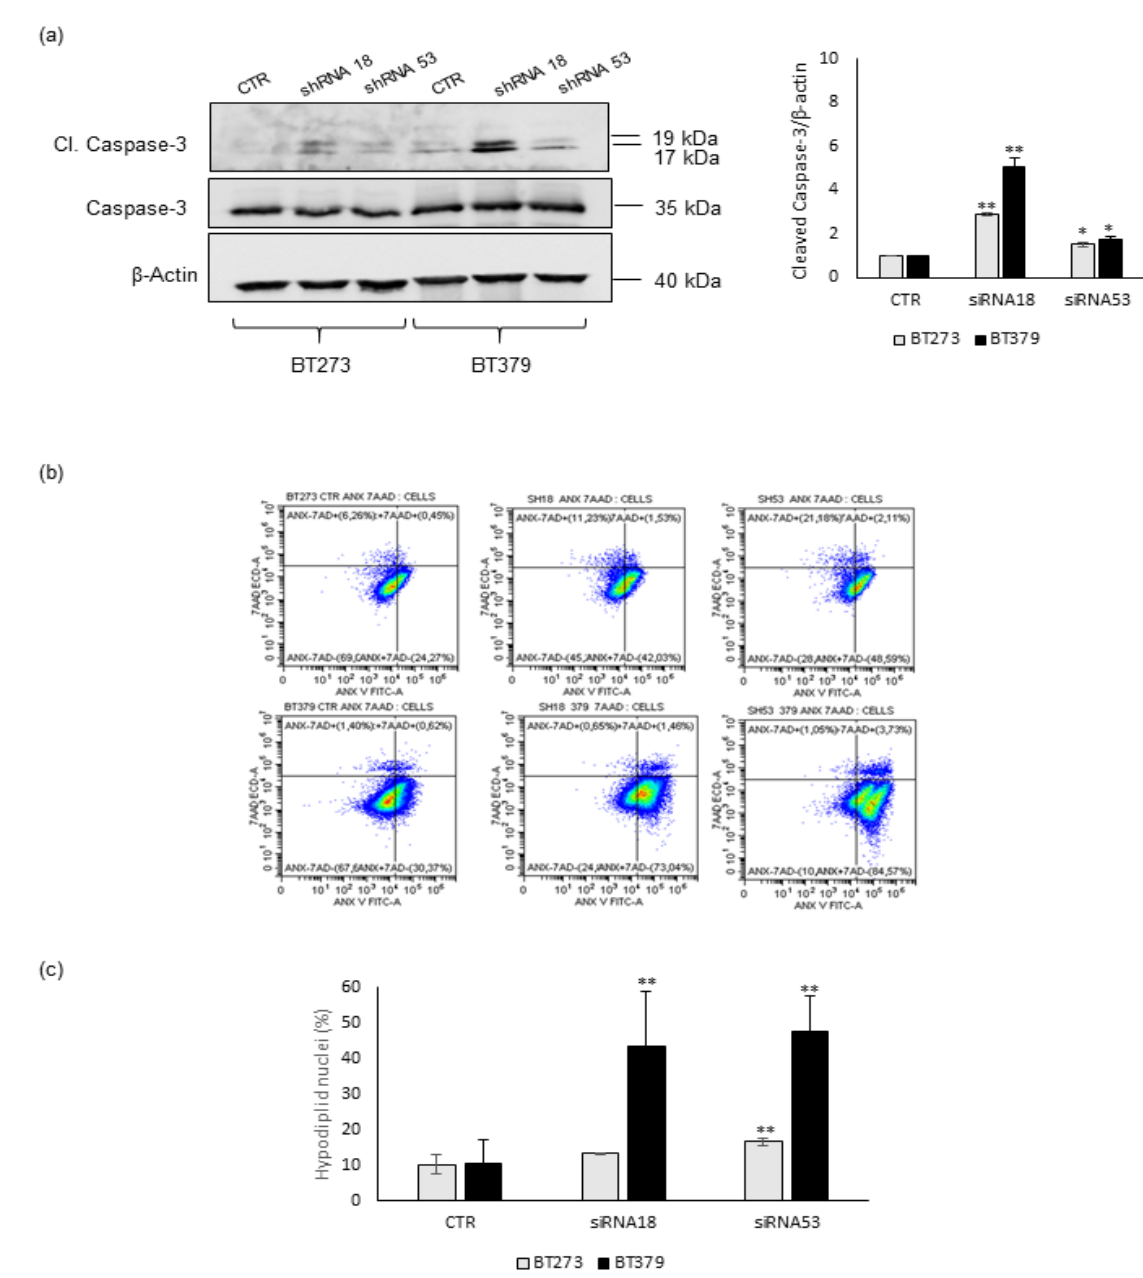
or ctrl lentiviral constructs. Histograms show the percentage of cells capable of re-forming a neuro- sphere seven days after dissociation ( n = 3; mean ± SD). Representative micrographs are shown. ( g , h ) Growth curves of BT273 ( g ) and BT379 ( h ) cells transduced with shRNA18 or shRNA53 or ctrl lentiviral constructs. ( n = 3; mean ± SD). Differences between two groups were assessed using un- paired Student’s t -test (two-tailed). Significance was defined as * p < 0.05; ** p < 0.01; *** p < 0.001, statistical difference compared to the control.